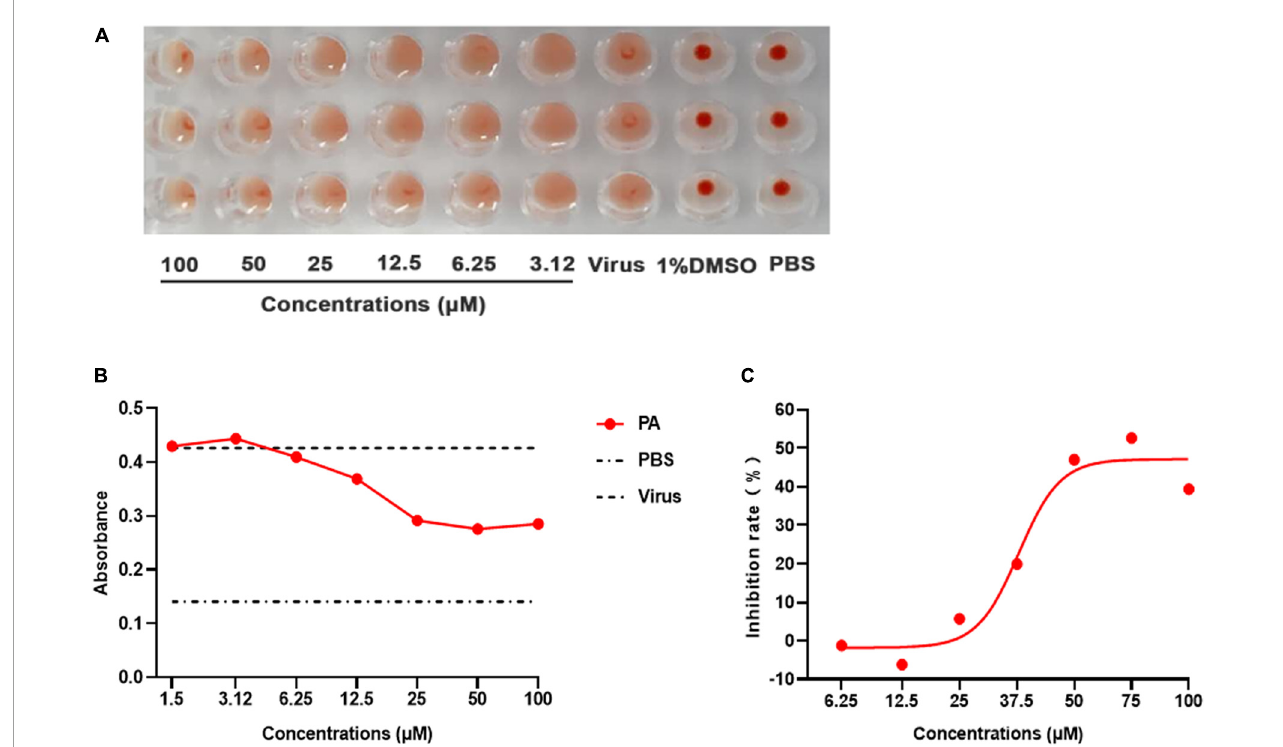
FIGURE7 Patchouli alcohol inhibits influenza A virus HA-mediated hemolysis. (A) The hemagglutination inhibiting assay. 25 µ L influenza virus A/Puerto Rico/8/34 (H1N1) strain was incubated with equal volume serially twofold Patchouli alcohol dilution at 4 ◦ C for 2 h, then 50 µ L of a 1% suspension of chicken red blood cells were added and incubated for 1 h at room temperature. The blank control was a PBS solution, n = 3, each concentration was conducted in triplicate. (B) Hemolysis inhibition assay of Patchouli alcohol against influenza virus. 100 µ L influenza A/Puerto Rico/8/34 (H1N1) strain virus was mixed in a 96-well-plate with an equal volume of serially twofold Patchouli alcohol dilution and incubated, 2% chicken red blood cell suspension was added after incubation and centrifuged. Then, sodium acetate at pH 5.0 was added and incubated to bring about hemolysis. The OD values were detected at 540 nm wavelength by a multimode microplate reader, n = 3, and each concentration was conducted in triplicate. (C) The inhibition rate of hemolysis of influenza A/Puerto Rico/8/34 (H1N1) strain virus at pH 5.0 by Patchouli alcohol, n = 3, each concentration conducted in